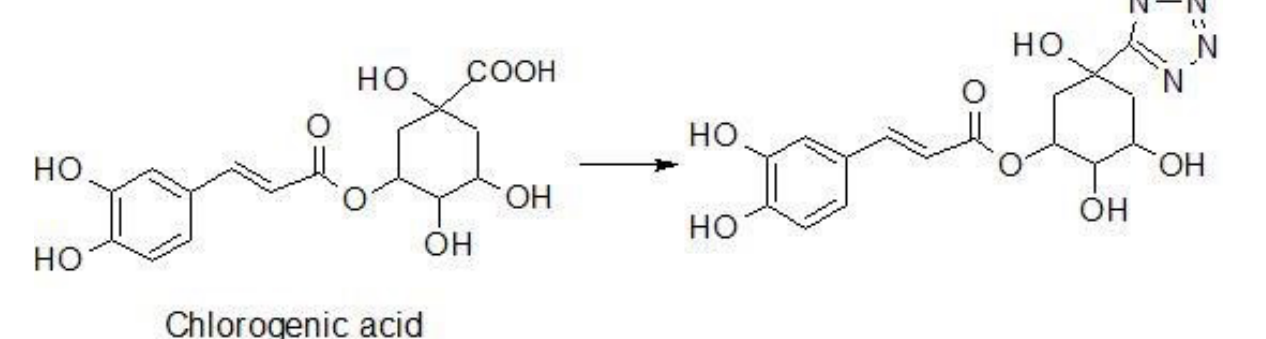
FIGURE 3 - Replacement of carboxyl group with tetrazole.